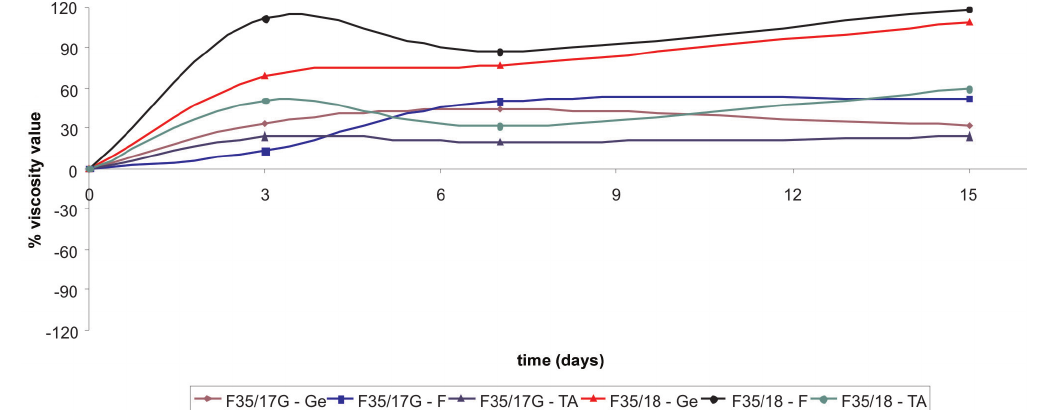
FIGURE 6. Percentage variation of apparent viscosity value for the test formulations F35/18 and F35/17G in the Refrigerator (Ge – 5.0 ± 1.0 °C), Freezer (F – -10.0 ± 1.0 °C) and Room Temperature (TA – 22.0 ± 2.0 °C) storage conditions in the